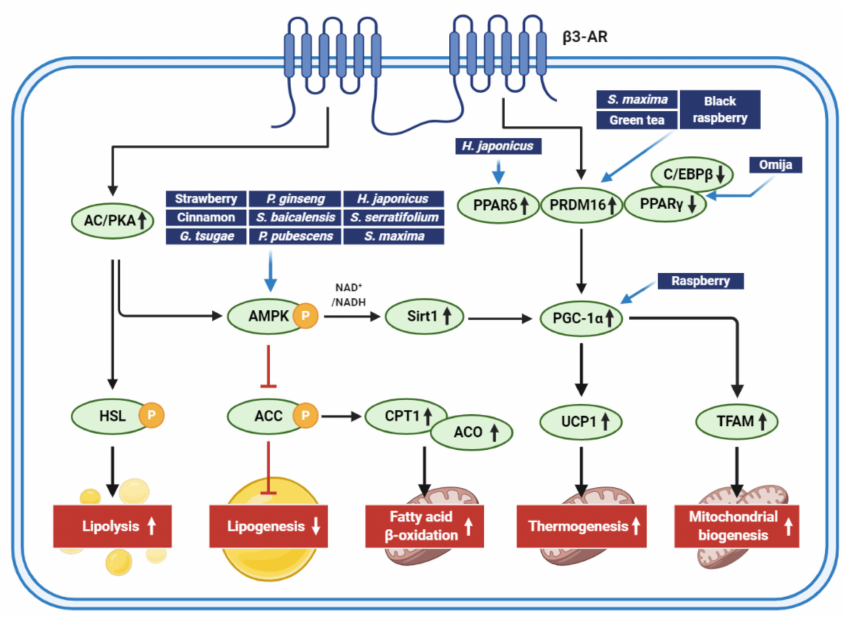
Figure 3. Signaling pathways regulated by extracts isolated from edible foods, plants, and marine products for adipocyte browning and antiobesity activities. The figure shows major pathways induc- ing lipid catabolism and mitochondrial functions that aid in weight loss. Although key molecules regulated by edible foods, plant extracts, and marine products for adipocyte browning and antiobe- sity effects are shown here, it should be noted that many extracts can, directly and indirectly, control multiple signaling pathways that regulate energy